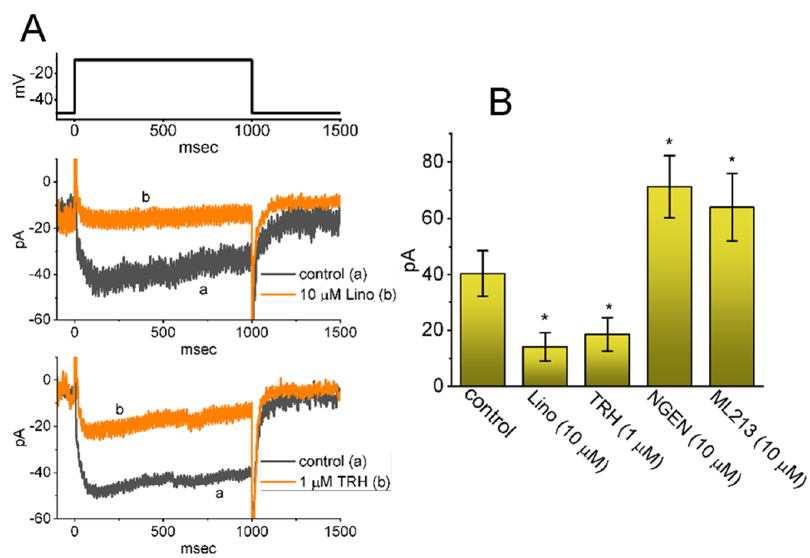
Figure 2. Effect of linopirdine (Lino), thyrotropin releasing hormone (TRH), naringenin (NGEN) or ML213 on M − type K + current (I K(M) ) recorded from pituitary tumor (GH 3 ) cells. These experiments were performed in cells which were kept bathed in high − K + , Ca 2+ − free solution containing 1 µ M TTX and 0.5 mM CdCl 2 , and we then backfilled the recording electrode by using K + − containing (145 mM) solution. ( A ) Representative current traces obtained in the control period (a’s) or during exposure (b’s) to 10 µ M Lino (upper part) or 1 µ M TRH (lower part). The uppermost part shows the voltage − clamp protocol used. ( B ) Summary bar graph showing effects of Lino, TRH, NGEN, or ML213 on the amplitude of I K(M) in GH 3 cells (mean ± SEM; n = 7 for each bar). Current amplitude was measured at the end of depolarizing pulse from − 50 to − 10 mV. Statistical analysis was made by ANOVA − 1 ( p < 0.05). * Significantly different from control ( p <